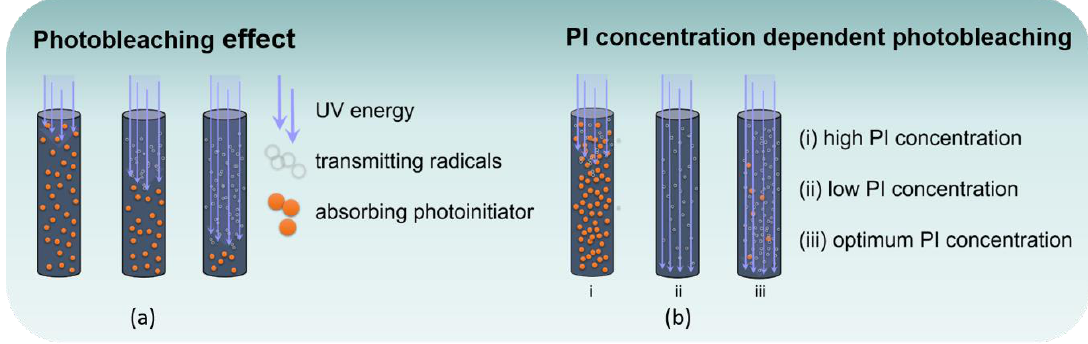
Figure 1. ( a ) Schematic representation of photofrontal polymerization, i.e., photobleaching during light exposure: absorbing photoinitiator (PI) molecules decompose into transparent products leading to an increase penetration depth. ( b ) PI concentration dependent penetration depth and curing: (i) high PI concentration resulting in increased absorption prevents deep penetration, (ii) low PI concentration enables high penetration depth with less radicals generated in the bottom region thus leading to low through-cure, (iii) with PI concentration in the optimum range, photobleaching allows light to penetrate into the bottom region still with enough radicals generated to achieve homogenous curing.